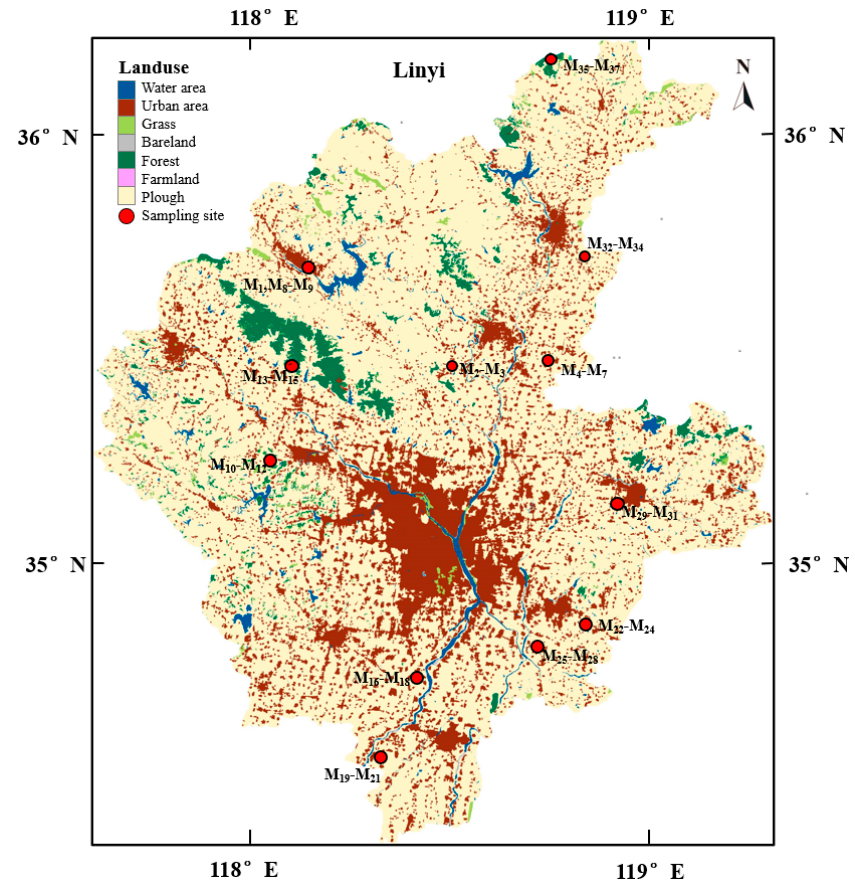
Figure 1. The sample sites and vegetation distributions of Linyi, Shandong Province. Table 1. The trace element data of the reference materials analyzed in this